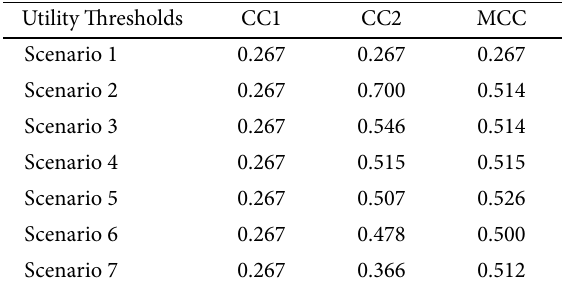
table 14. Utility thresholds for 7 scenarios